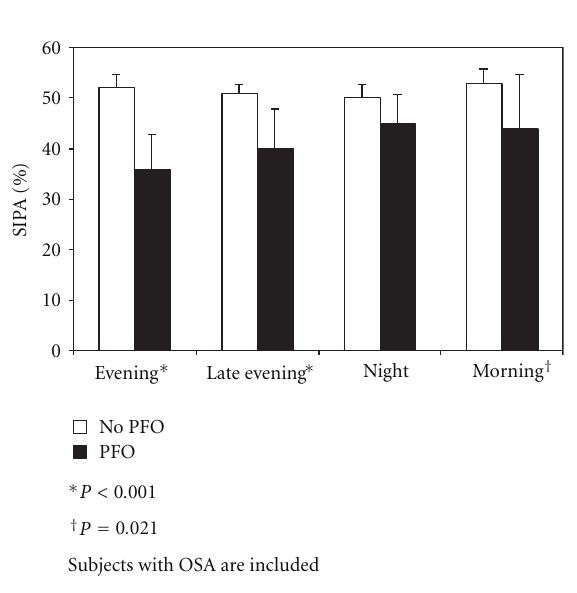
periods or to some other mechanism. Our finding that the presence of PFO predicts a PAI-1: Ag increment during sleep is a novel one and needs confirmation. Previous data on the relationship between PFO and coagulation factors do not include PAI-1 (activity or antigen) [10]. SIPA was significantly lower in the subjects with PFO than in subjects without PFO, but it tended to increase during the night. The reason for this remained